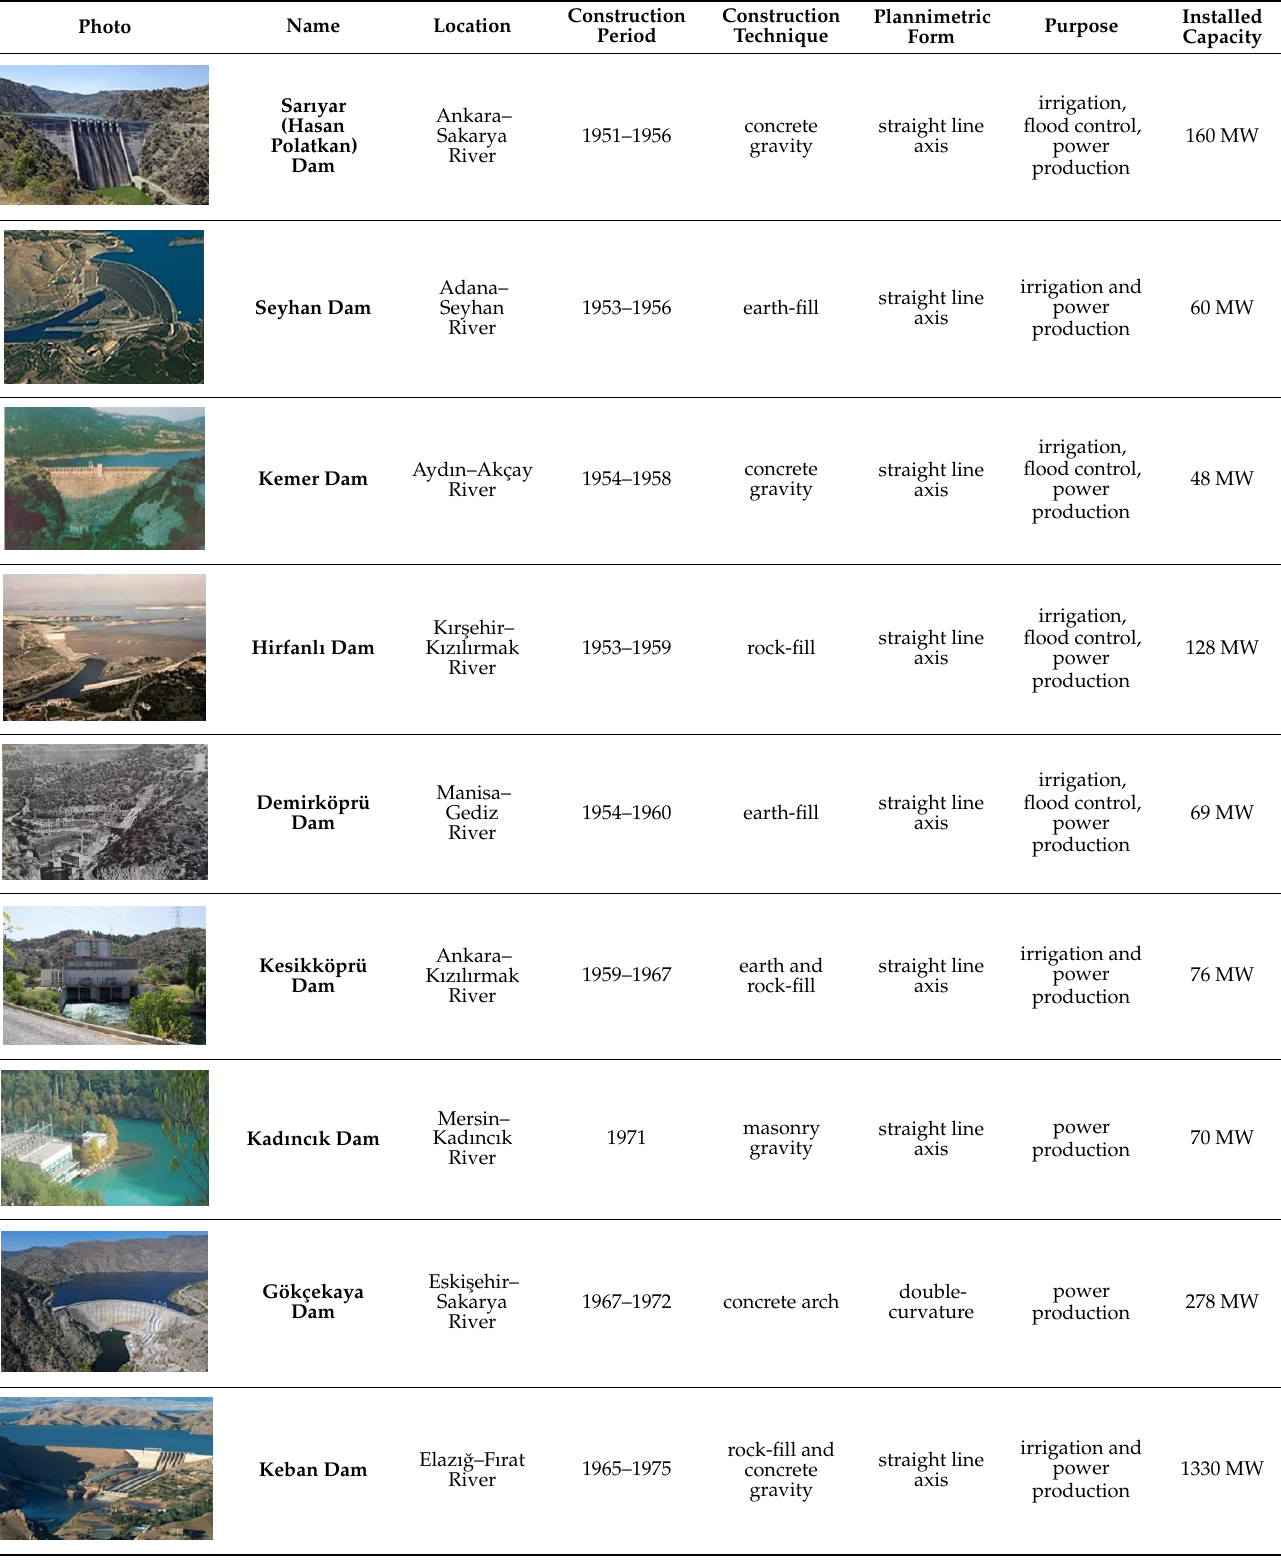
Table 2. Documentation of hydroelectric plants (with the installed capacity over 50 MW) constructed before 1975 in Turkey. Photo